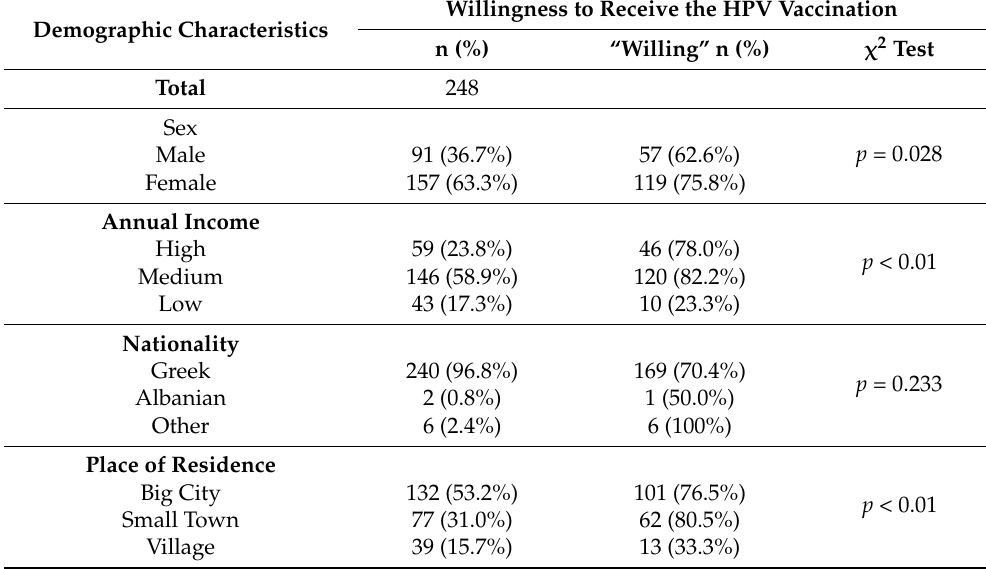
Table 4. Phase II: demographic characteristics of the intervention group correlated with willingness to receive the HPV vaccination (n =